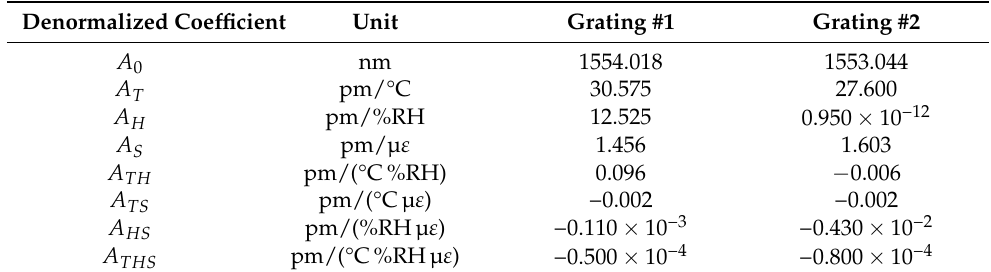
Table 6. Denormalized main and cross sensitivities of FBG in CYTOP fiber with (Grating #1) and without over-clad (Grating #2).